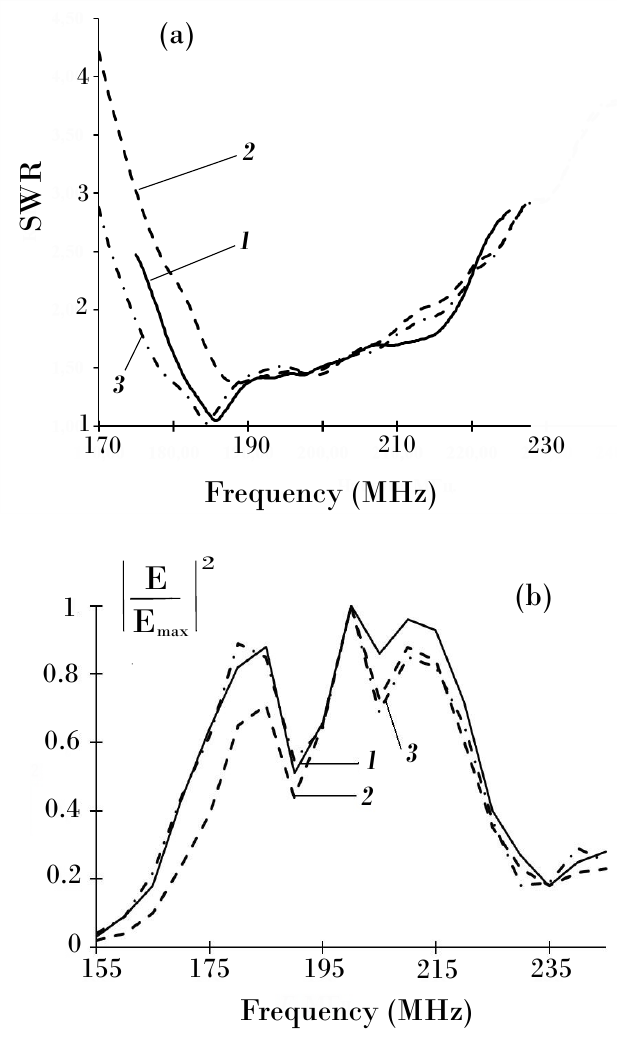
Figure 3. Dipole antenna operating at 200 MHz. ( a ) SWRs and ( b ) Square of the normalized field amplitude of the emitted signal as a function of frequency for 3 different prototypes with (i) metal radiating elements (curve 1, solid line), (ii) a longitudinal laying of the fiber on the fluoroplastic insert (curve 2, dashed line), and (iii) curricular winding of the fiber on the duralumin insert (curve 3, dashed-dotted line). E max is the maximum value of the field